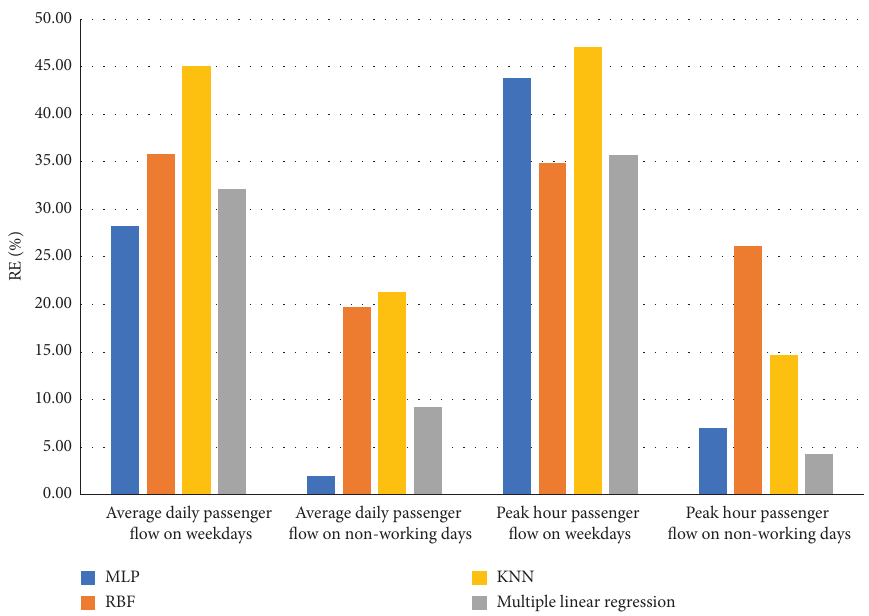
Figure 20: Comparison of prediction results of Sanyuanqiao